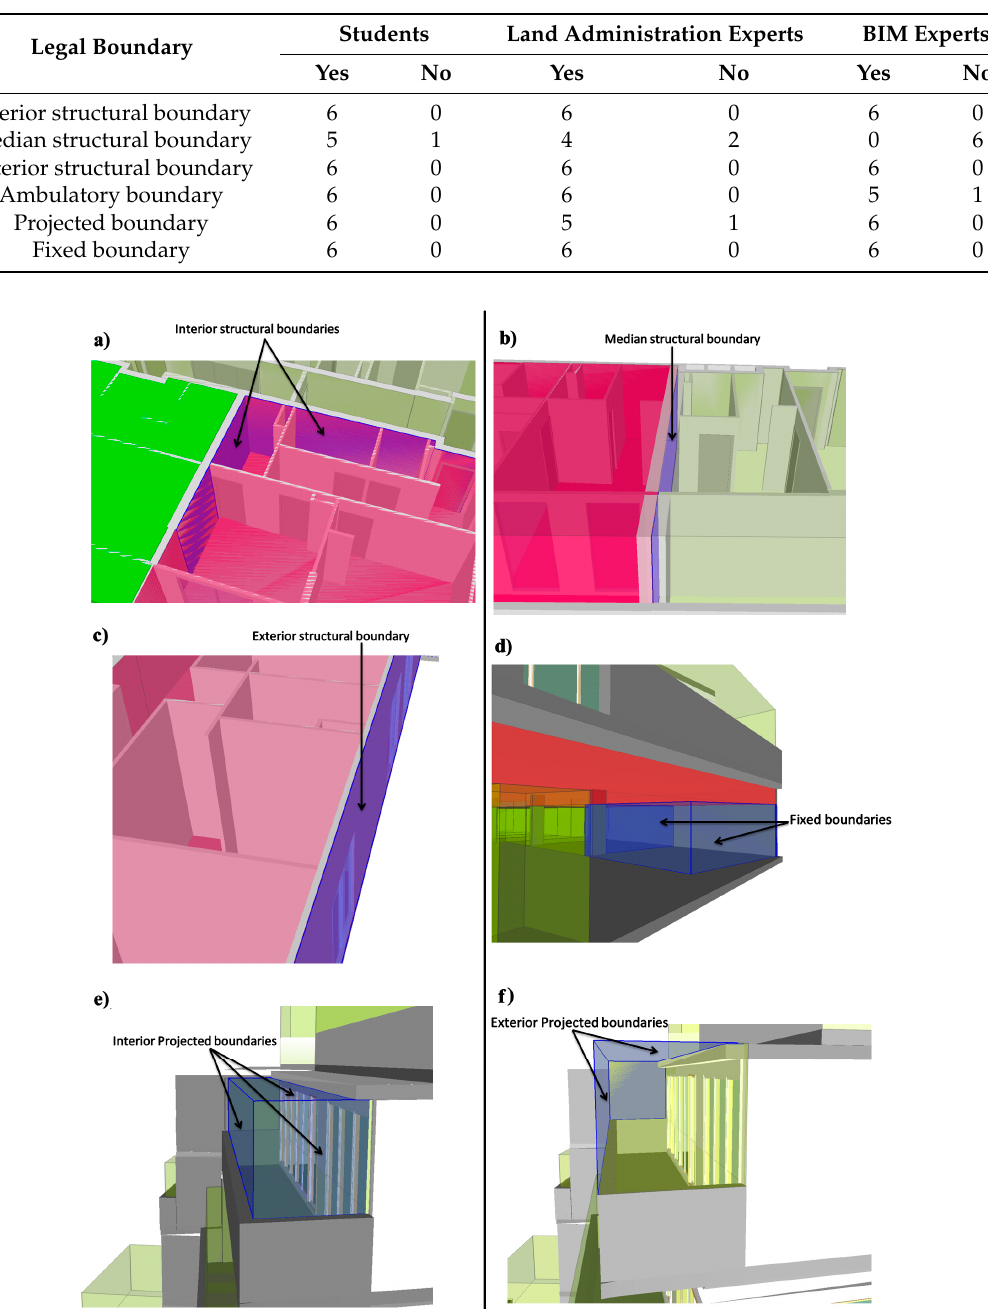
Table 5. Responses to visual understanding of legal boundaries in the integrated model.